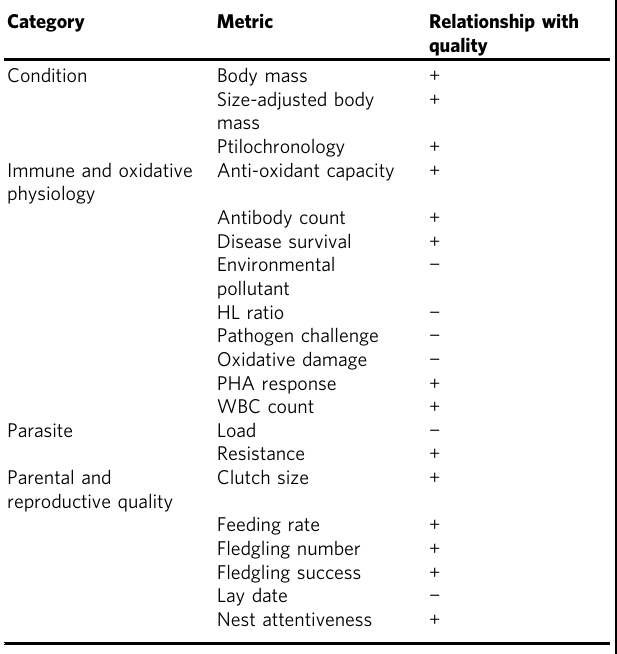
published data from a sister-species of the same genus that displayed the same feather color.